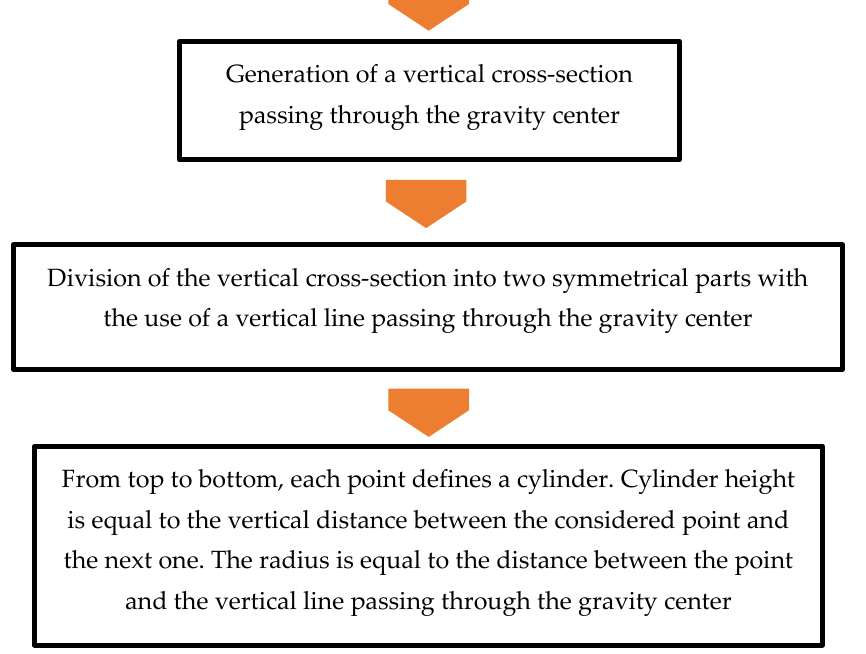
Figure 4. Workflow of a modeling algorithm for generating a building composed of rotational surfaces.